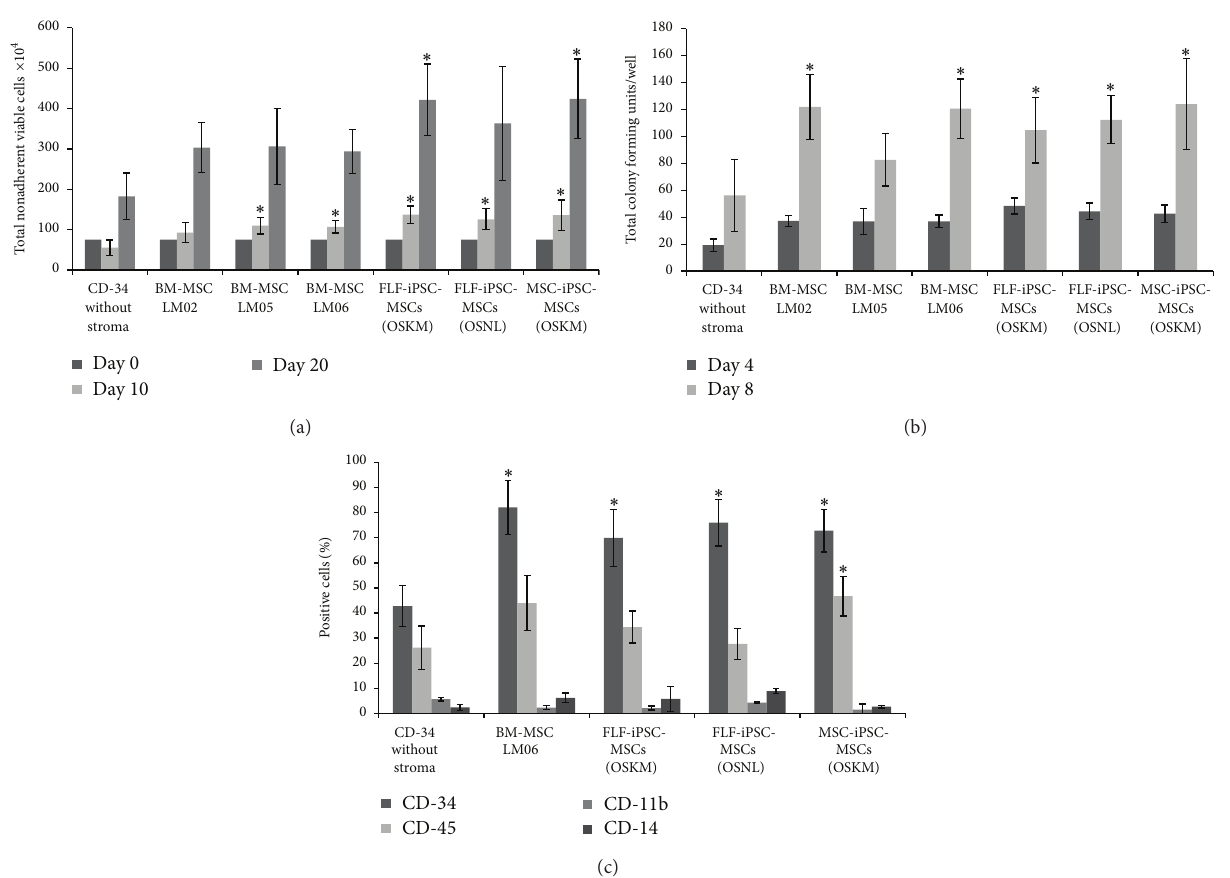
Figure 5: Coculture of CD34 + PBMCs with human iPSC-MSCs. (a) Cell layers of iPSC-MSCs and BMSCs were established on 1% gelatin precoated 24-well plates (80% confluent). CD34 + PBSCs were applied onto the stromal layers. The cocultures were incubated for 20 days. Nonadherent viable cells were counted at the indicated time points, (b) human CD34 + were plated with hiPSC-MSCs in 0.5 mL of methylcellulose media containing human recombinant IL-3, SCF, and Epo. The plates were incubated for 20 days following which progenitors were scored, (c) surface markers expression on CD34 + cells after coculture with mesenchymal stromal cells. The results represent the mean ( ± SD) of three replicates. ∗ : significance difference with CD34 without stroma 𝑝 ≤ 0.05